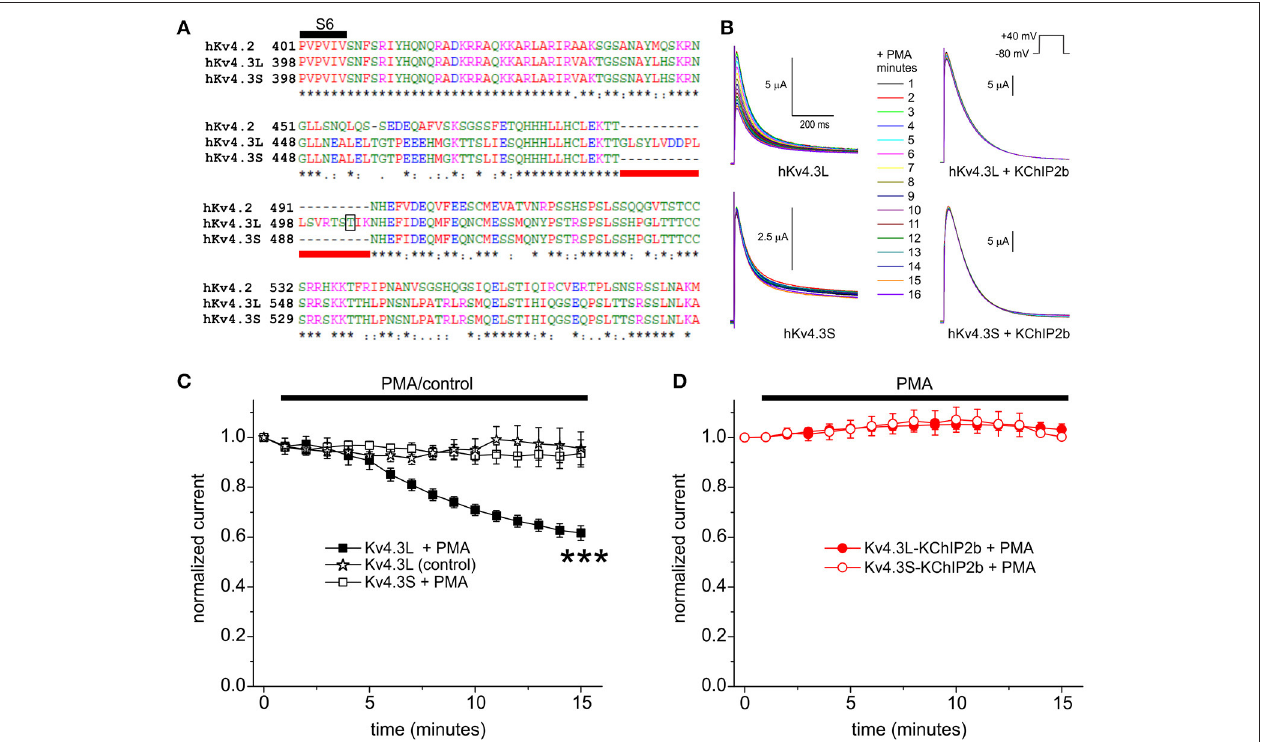
FIGURE 1 | KChIP2b protects Kv4.3L from inhibition by PKC phosphorylation. (A) Sequence alignment (Clustal TCoffee) of the C-terminal end of human Kv4.2, Kv4.3L and Kv4.3S protein sequences, including the segment missing in Kv4.3S (underlined red) and the T504 PKC phosphorylation site (open box). *Conserved in all three sequences. Adapted from Abbott (2017). (B) Exemplar current traces recorded during + 40 mV pulses (1 per minute) in the presence of 50 nM PMA, from Xenopus oocytes 36–56 h after injection of 1.5 ng cRNA encoding Kv4.3L or Kv4.3S, with ( n = 7–12) or without ( n = 6–7) 5 ng KChIP2b. Insets: center, color-coded key to traces; upper right, voltage clamp protocol. (C) Mean ± SEM normalized peak current magnitude at + 40 mV during incubation in 50 nM PMA or normal bath solution (control) for Kv4.3 currents recorded in the absence of KChIP2b as in (B) ( n = 6–7). *** P < 0.001 vs. other groups at 15 min. (D) Mean ± SEM normalized peak current magnitude at + 40 mV during incubation in 50 nM PMA (unless indicated) for Kv4.3-KChIP2b currents recorded as in (B) ( n =